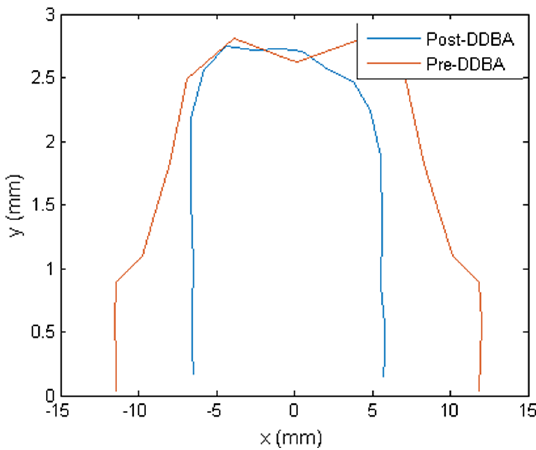
FIG. 14. Measured dynamic aperture before (red) and after (blue) the installation of DDBA cell, scaled at the injection point.